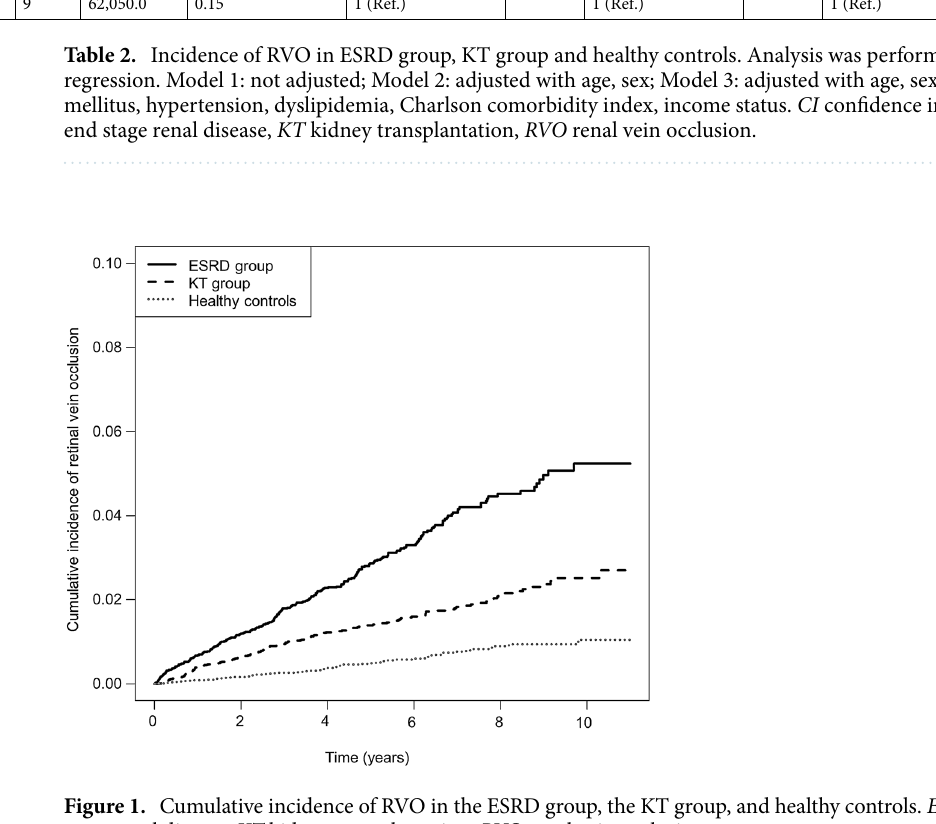
Figure 1. Cumulative incidence of RVO in the ESRD group, the KT group, and healthy controls. ESRD end- stage renal disease, KT kidney transplantation, RVO renal vein